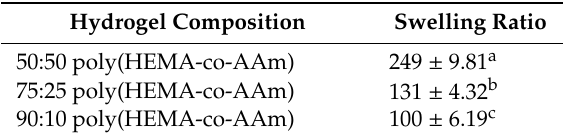
Table 1. Swelling ratios of urate